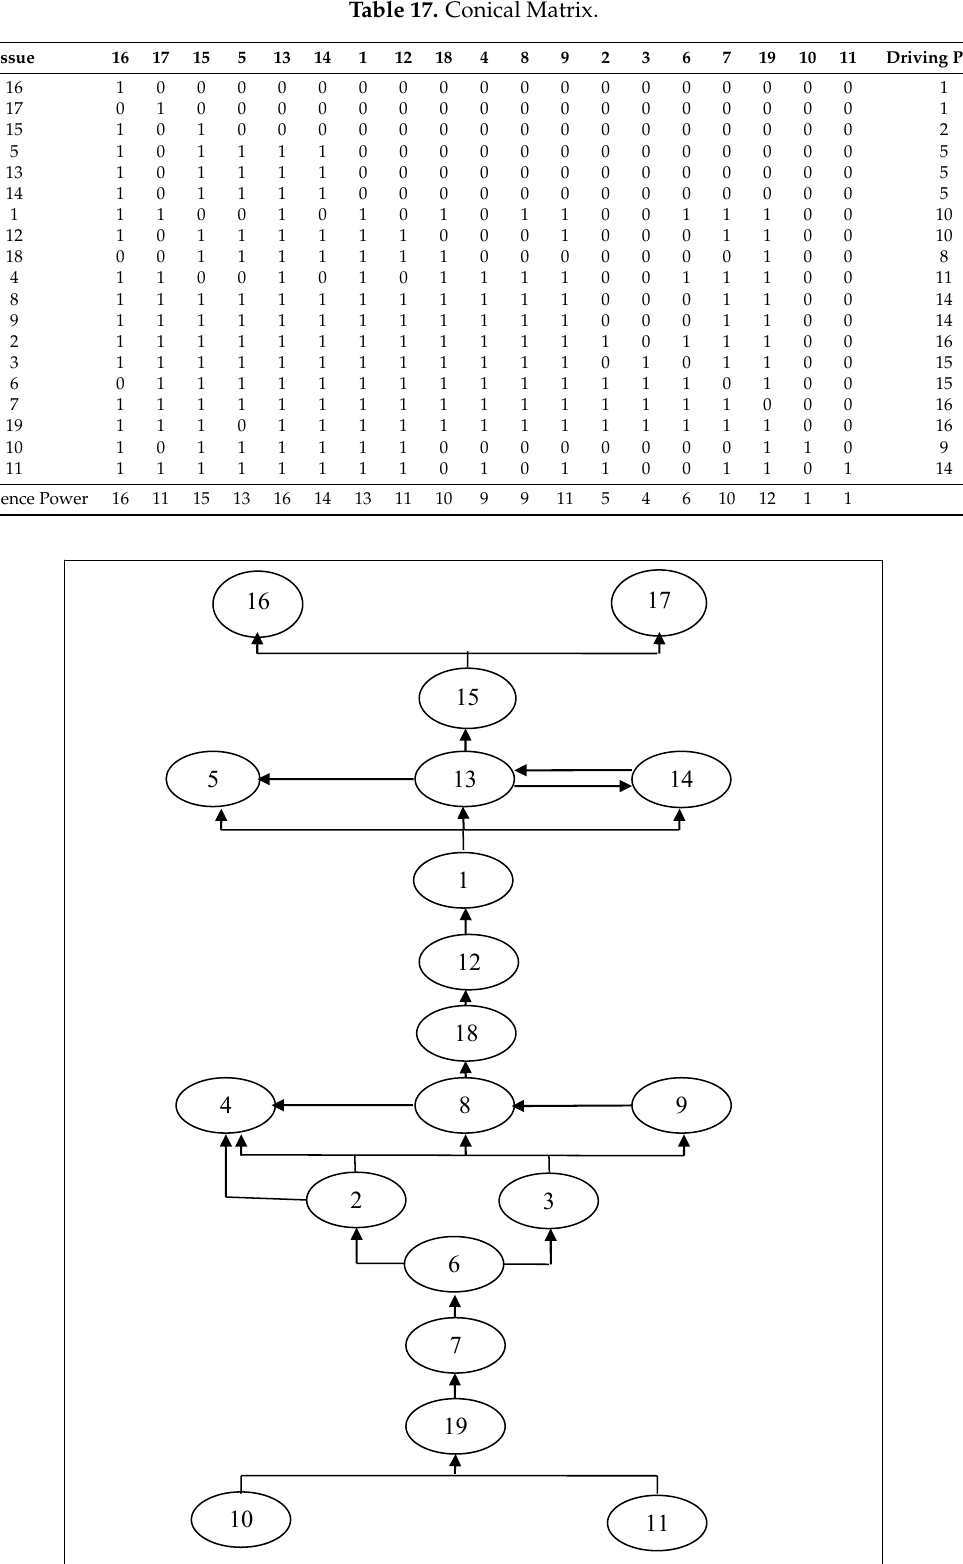
Figure 1. A digraph showing the relationship between different material handling issues in FMS.